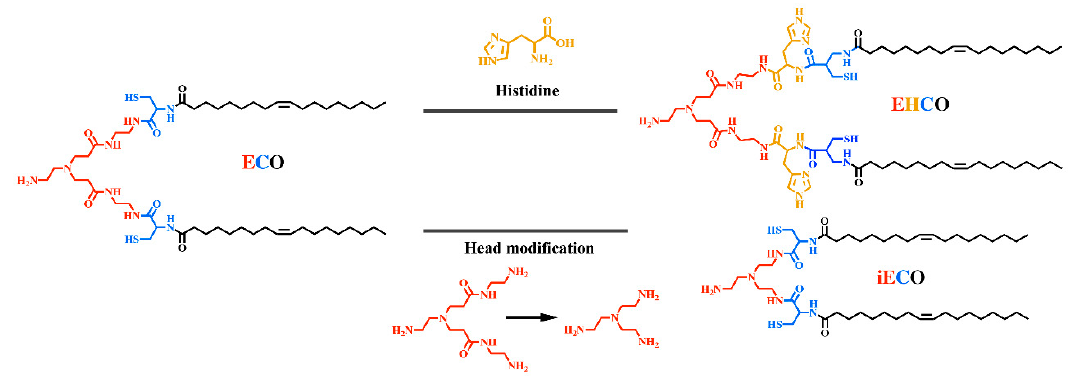
Figure 2. Chemical structure of ECO, EHCO and isotypic ECO. E: Ethylenediamine; C: Cysteine; O: Oleic acid; H: Histidines.